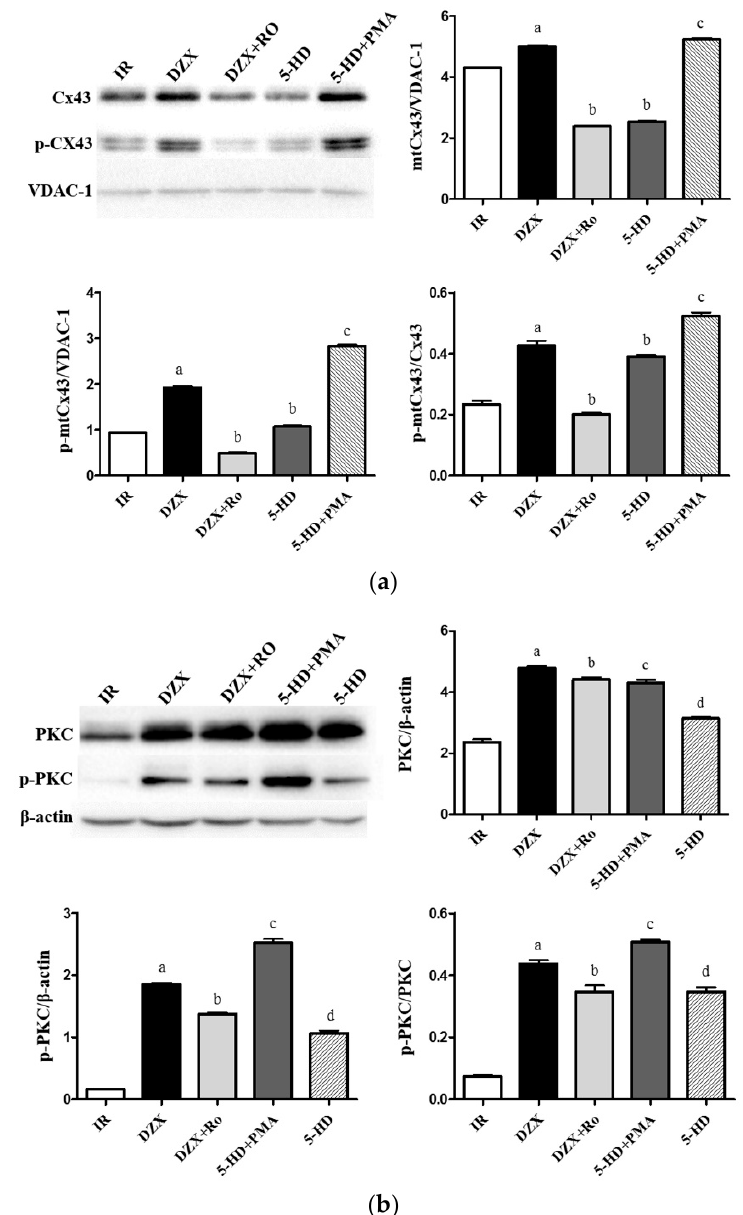
Figure 7. Effects of interference with PKC ε on expression of mtCx43, p-mtCx43, PKC ε , and p-PKC ε in the rat cerebral cortex after ischemia-reperfusion injury. ( a ) The expression of mtCx43 and p-mtCx43 in different groups. Data are presented as mean ± standard deviation, n = 6 in each group. F (mtCx43) = 3916, p ≤ 0.05; F (p-mtCx43) = 3578, p ≤ 0.05; F (p-mtCx43/Cx43) = 405.5, p ≤ 0.05; a p ≤ 0.05 vs. IR group; b p ≤ 0.05 vs. DZX; c p ≤ 0.05 vs. 5-HD group; ( b ) The expression of PKC ε and p-PKC ε in different groups. Data are presented as mean ± standard deviation, n = 6 in each group. F (PKC ε ) = 413.3, p ≤ 0.05; F (p-PKC ε ) = 1499, p ≤ 0.05; F (p-PKC ε /PKC ε ) = 280.1, p ≤ 0.05; a p ≤ 0.05 vs. IR; b p ≤ 0.05 d p ≤ 0.05 vs. DZX; c p ≤ 0.05 vs. 5-HD. 5-HD: 5-hydroxydecanoic acid; Cx43: connexin 43; DZX: diazoxide; IR: ischemia-reperfusion; PMA: phorbol-12-myristate-13-acetate; Ro: Ro-31-8425; VDAC: voltage-dependent anion channel.